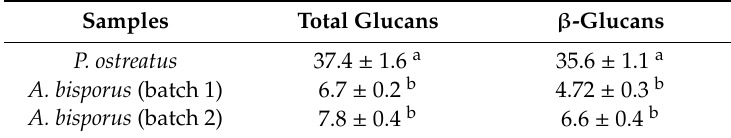
Table 1. Content of total glucans (mean ± SD , g / 100 g d.w.) and β -glucans (mean ± SD g / 100 g d.w.) in P. ostreatus and A.